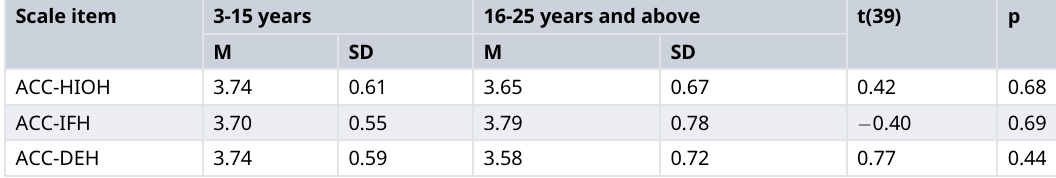
Table 4. Comparisons of mean scores of acceptance of eHealth domains for mental wellness between work experience groups using independent sample t-tests. Scale